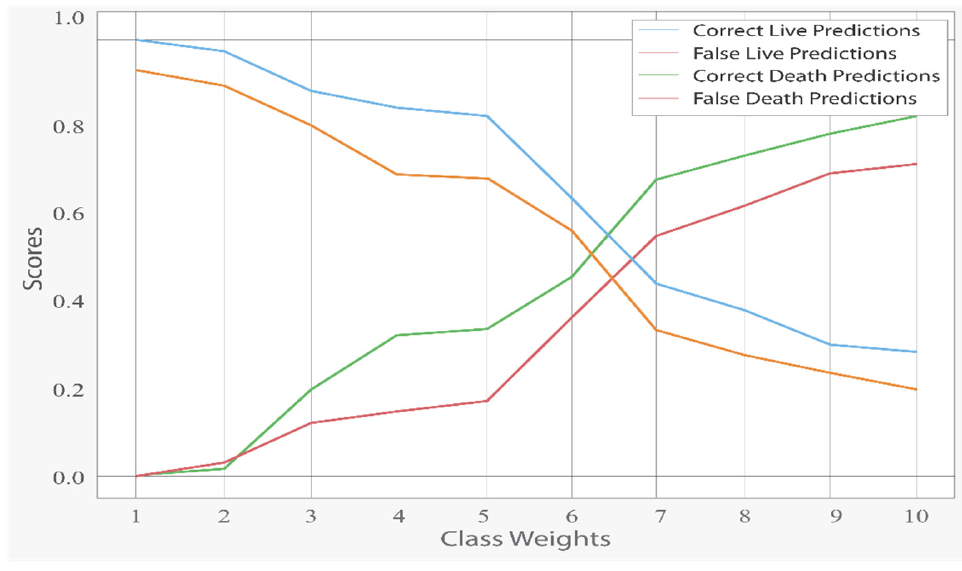
Figure 3. Summary of the precision–recall curve.